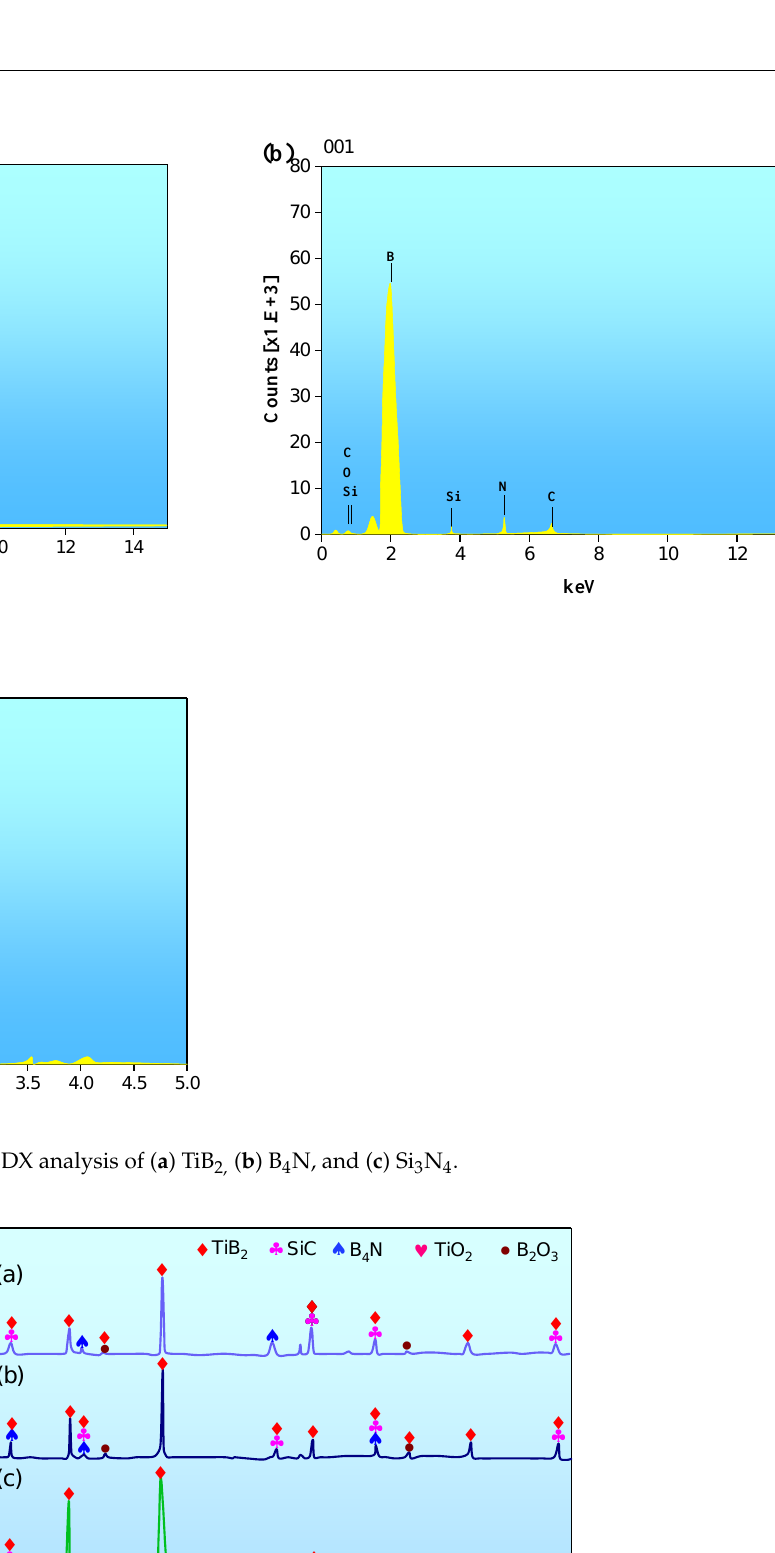
Figure 3. XRD of the as-received powder.